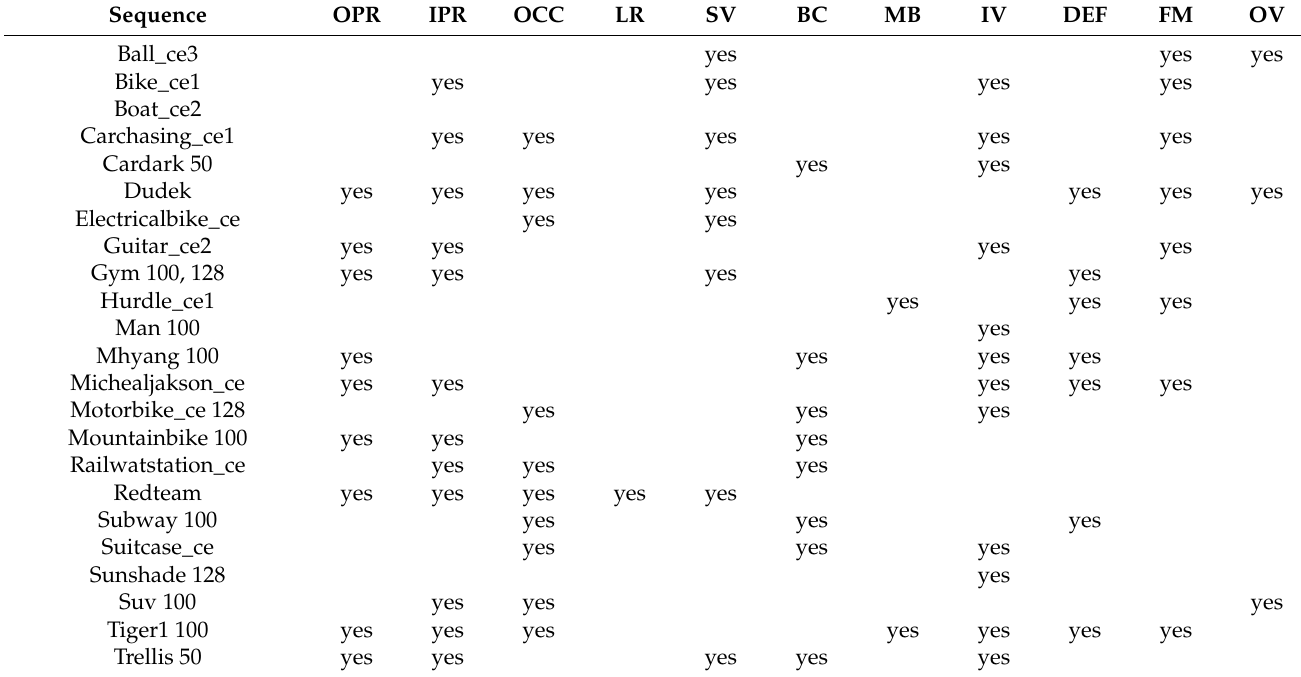
Table 1. Challenges associated with selected